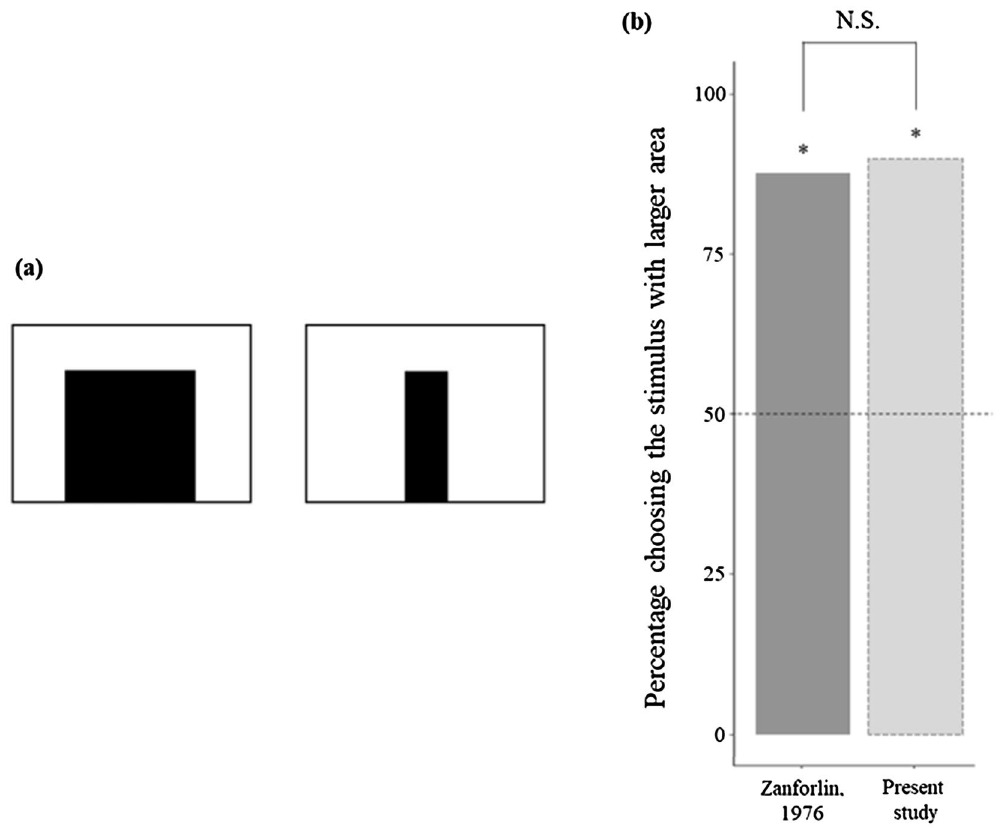
Figure 7. ( a ) Replication of one experiment conducted by Zanforlin 41 . ( b ) Percentage of snails choosing the larger stimulus shown in the previous study 41 (dark grey) and in the current study (light grey). Preference did not differ between the two studies ( P = 0.803). Dotted line represents the expected preference by chance, and asterisks indicate significant deviations from the chance level ( P <